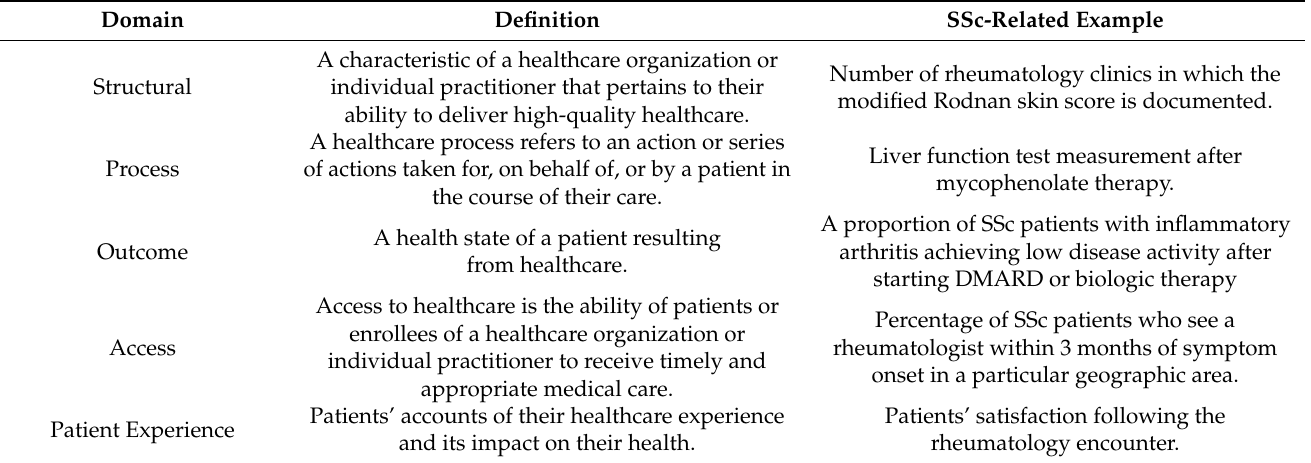
Table 1. Healthcare quality measure domains and systemic sclerosis-related